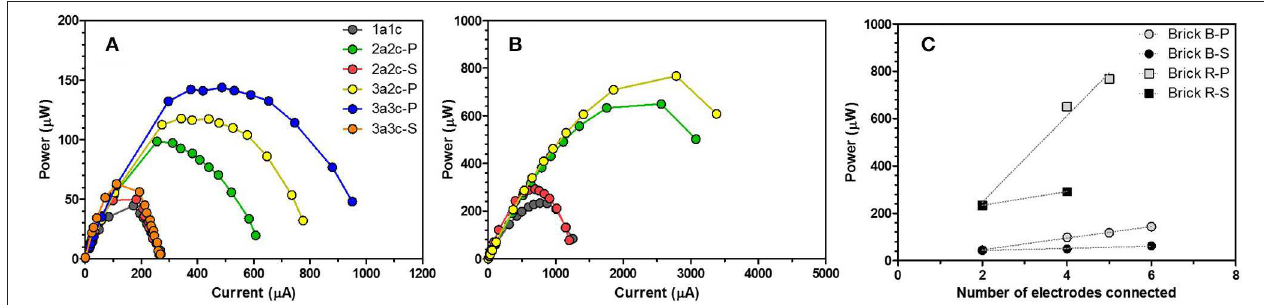
FIGURE 3 | Power curves of the best cathode of each tested Type 1 brick and maximum power output of each polarisation sweep. (A) B_AC_Na wet cathode (B) R_AC_PTFE wet cathode (C) maximum power output of each configuration in relation to the total number of electrodes (both anode and cathode) connected. In the legend, figures indicate the number of anodes or cathodes connected, letters “a,” “c,” “P,” and “S” represent anode electrode, cathode electrode, parallel connection and serial connection,